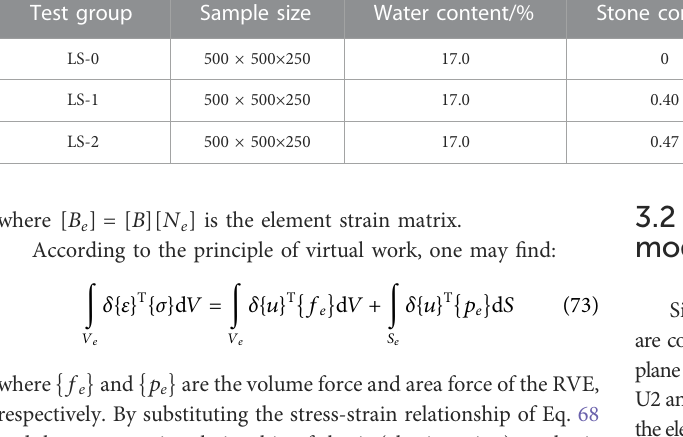
TABLE 2 Scheme of large-scale direct shear